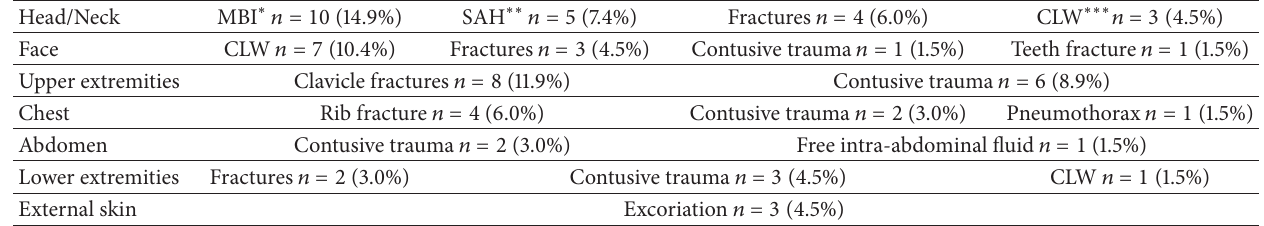
Table 3: Number and type of injuries for each body